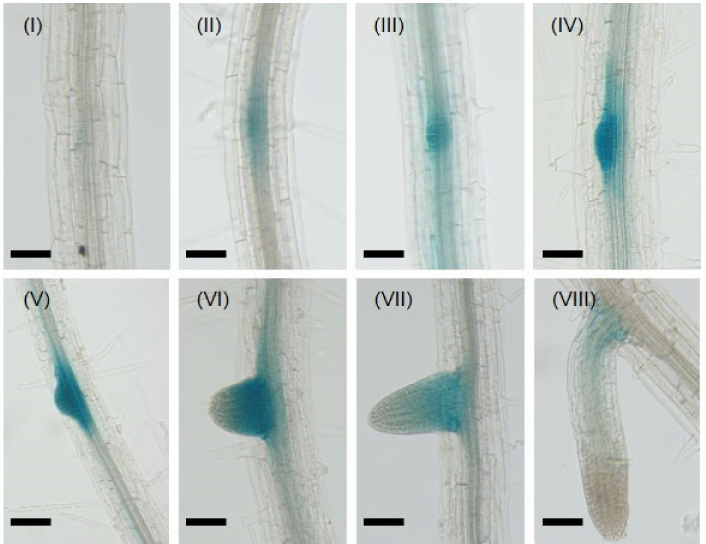
Figure 1. AtCML8 is transiently expressed during lateral root formation. GUS activity staining was observed on seven days-old promoter CML8::uidA transgenic Arabidopsis seedlings. ( I ) to ( VIII ) photos correspond to the eight developmental stages as described in [31]. Bars: 50 µ